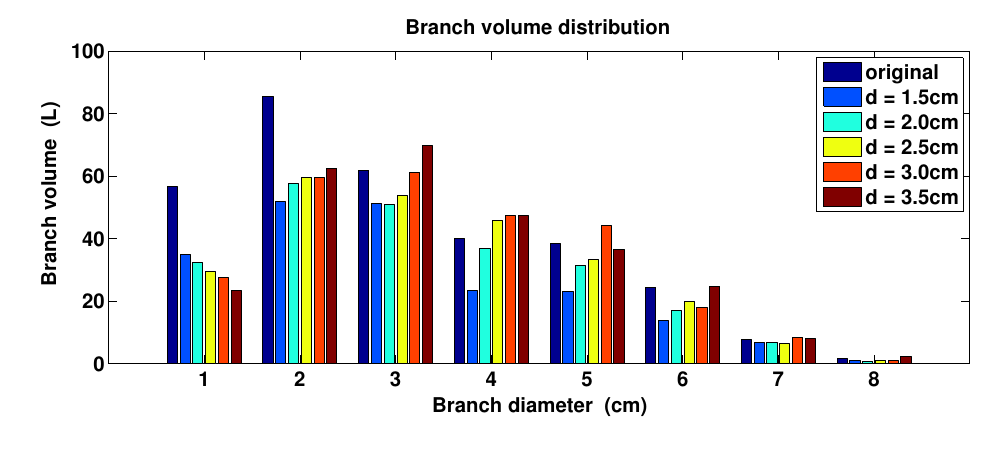
Figure 14. Branch size